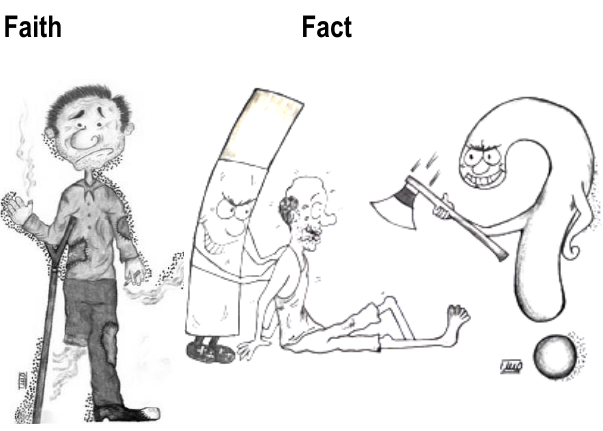
Figure 2. The left cartoon illustrates the faith in TAO and smoking. The right cartoon depicts the current concept on smoking and TAO. Smoking exposes patients to an unknown trigger and confounds the disease development.